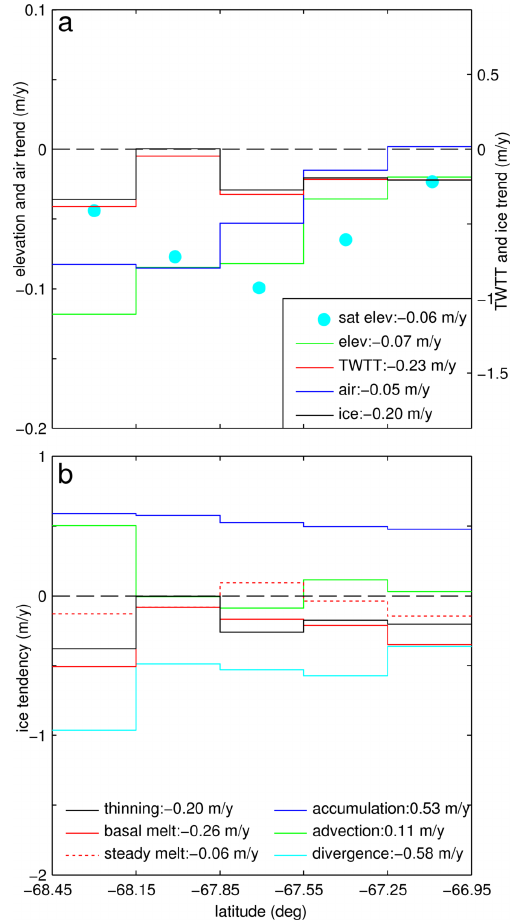
Figure 5. Spatial variation in derived quantities along the sur- vey line within latitude bins centred on the locations of the satel- lite crossover points (see Fig. 1b). (a) Trends in elevation (green), TWTT (red; ice equivalent), and air (black) and ice (blue) thickness showing significant ice and air loss. Elevation trends derived from satellite radar altimetry at the crossovers are cyan. Elevation and air thickness use the left axis, while TWTT and ice thickness are plotted with absolute values on the right axis and equivalent surface elevation on the left axis. (b) Spatial variation in ice mass budget. Divergence balances accumulation, and ice thinning is similar to un- balanced basal melting. Values in the legends represent means over all